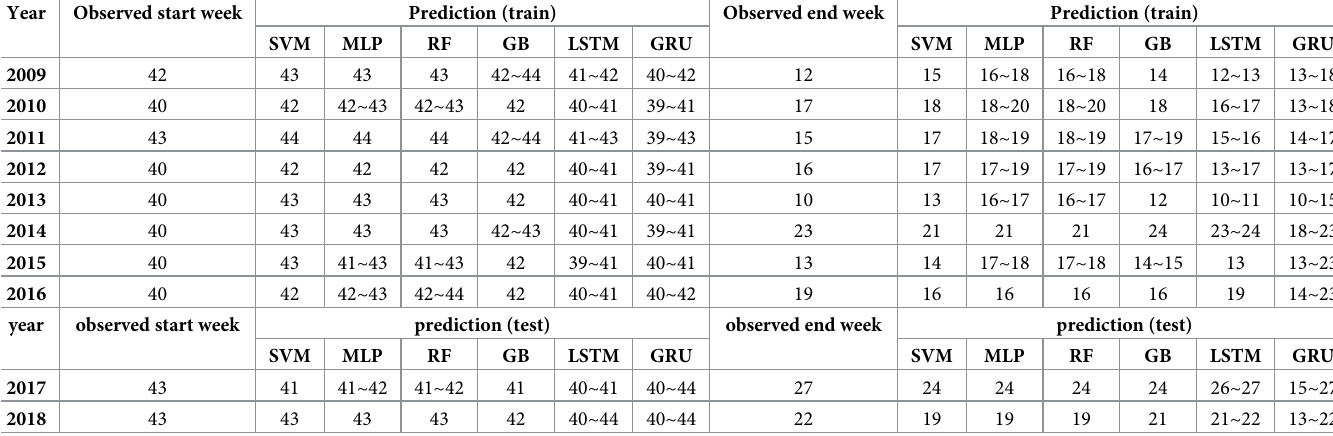
Table 2. Comparison of observed start and end week of norovirus warning phase and predicted start and end week time interval of early detection of norovirus in 6 machine learning algorithms.